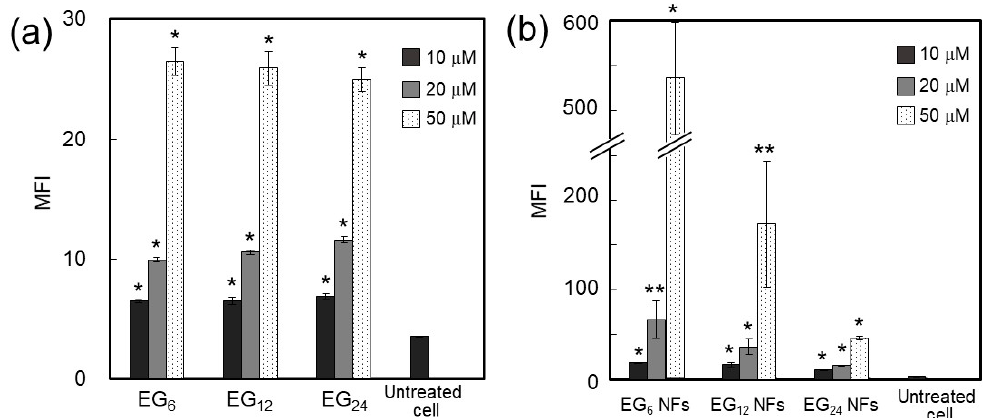
Figure 5. Evaluation of the cellular association of various ( a ) EG n peptides and ( b ) EG n NFs labeled with fluorescein using FCM. Mean fluorescence intensity of the treated JAWS II cells is shown. Cellular treatment was performed by incubating cells with peptides or NFs in serum-free medium at 37 °C for 2 h. Each point is the mean ± SD ( n = 3). * p < 0.01, ** p < 0.01 compared to untreated cell.